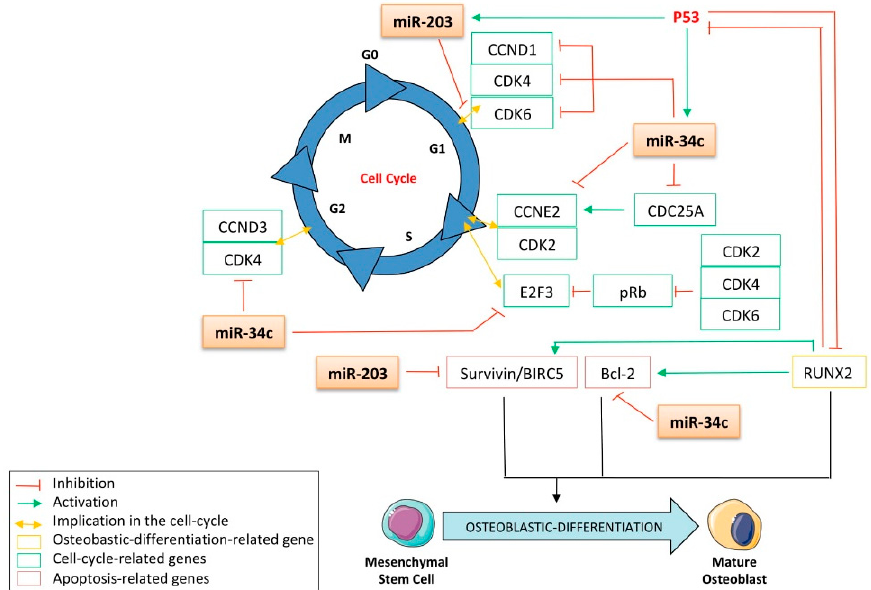
Figure 9. The p53-related miRNAs’ control of the cell cycle and apoptosis is linked to the role as osteoblastic-differentiation regulators. CCN: cyclin; CCND1: cyclin D1; CCND3: cyclin D3; CCNE2: cyclin E2; CDC25A: cell division cycle 25A; CDK: cyclin-dependent kinase; CDK2: cyclin-dependent kinase 2; CDK4: cyclin-dependent kinase 4; CDK6: cyclin-dependent kinase 6; Bcl-2: B-cell CLL/Lymphoma 2; RUNX2: runt-related transcription factor 2.